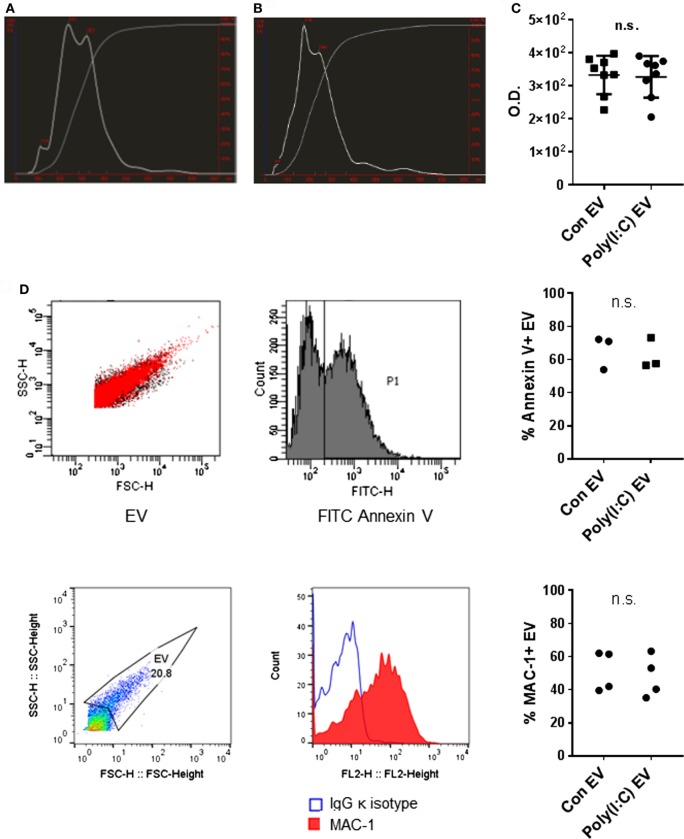
Characterization of U937 cell-derived extracellular vesicles (EV). Size distribution of particles (white line) and cumulative percentage of particles under given size (gray line) in EV preparations from (A) untreated U937 cells and (B) Poly(I:C)-stimulated U937 cells as detected by nanoparticle tracking analysis, shown is one of n = 2 biological replicates per condition. (C) Total protein amount in EV from untreated U937 cells (Con EV) and Poly(I:C)-stimulated U937 cells [Poly(I:C) EV] as measured by BCA Protein Assay, n = 8 biological replicates, mean ± SD. (D) Binding of FITC Annexin V to the surface of Con EV and Poly(I:C) EV with SSC-H/FSC-H profile of EV and histogram of FITC-labeled Annexin V binding, shown is one sample of n = 3 biological replicates per condition. Percentage of Annexin V-positive EV as measured by flow cytometry. (E) The expression of MAC-1 on the surface of Poly(I:C) EV with SSC-H/FSC-H profile of EV and FL2 histogram of MAC-1 positivity, as measured by flow cytometry. Shown is one sample of n = 4 biological replicates per condition. Percentage of MAC-1-positive EV as measured by flow cytometry. Statistics: (C–E) two-tailed paired t-test, ns, not significant.